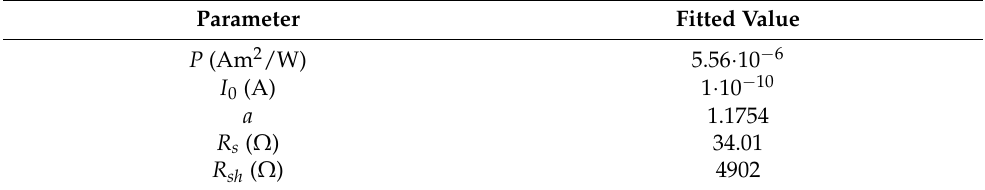
Table 2. Value of the model parameters (see Equations (1) and (10)), fitted to the testing data of the photodiode SS1-X+ Figure 10.